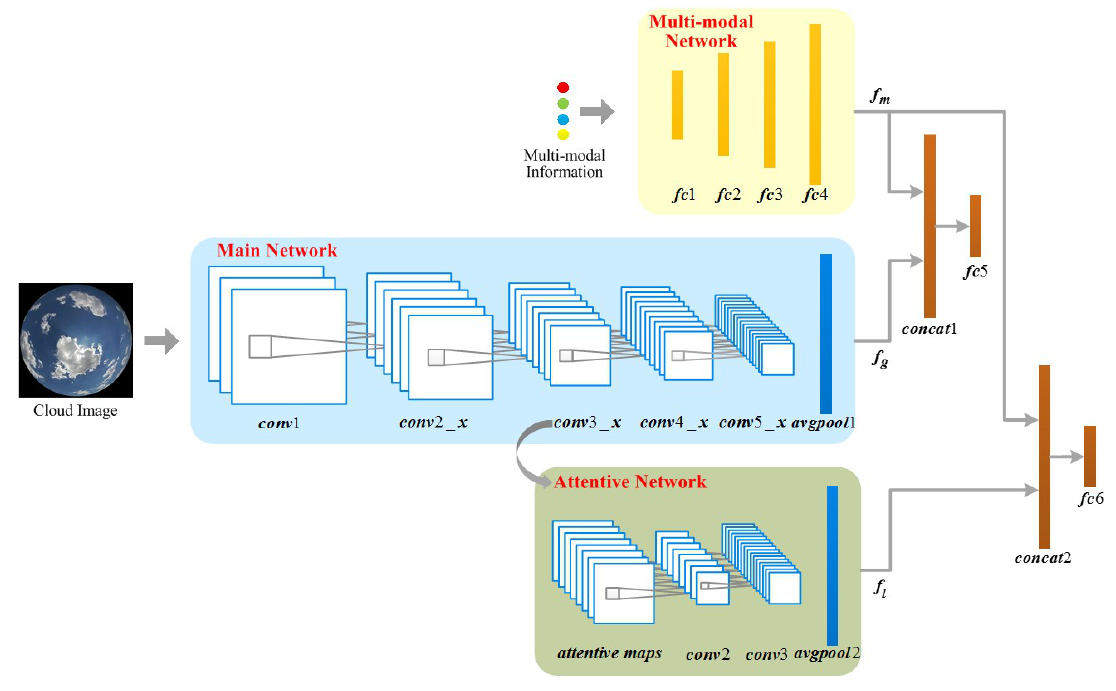
Figure 2. The architecture of the proposed multi-evidence and multi-modal fusion network (MMFN).